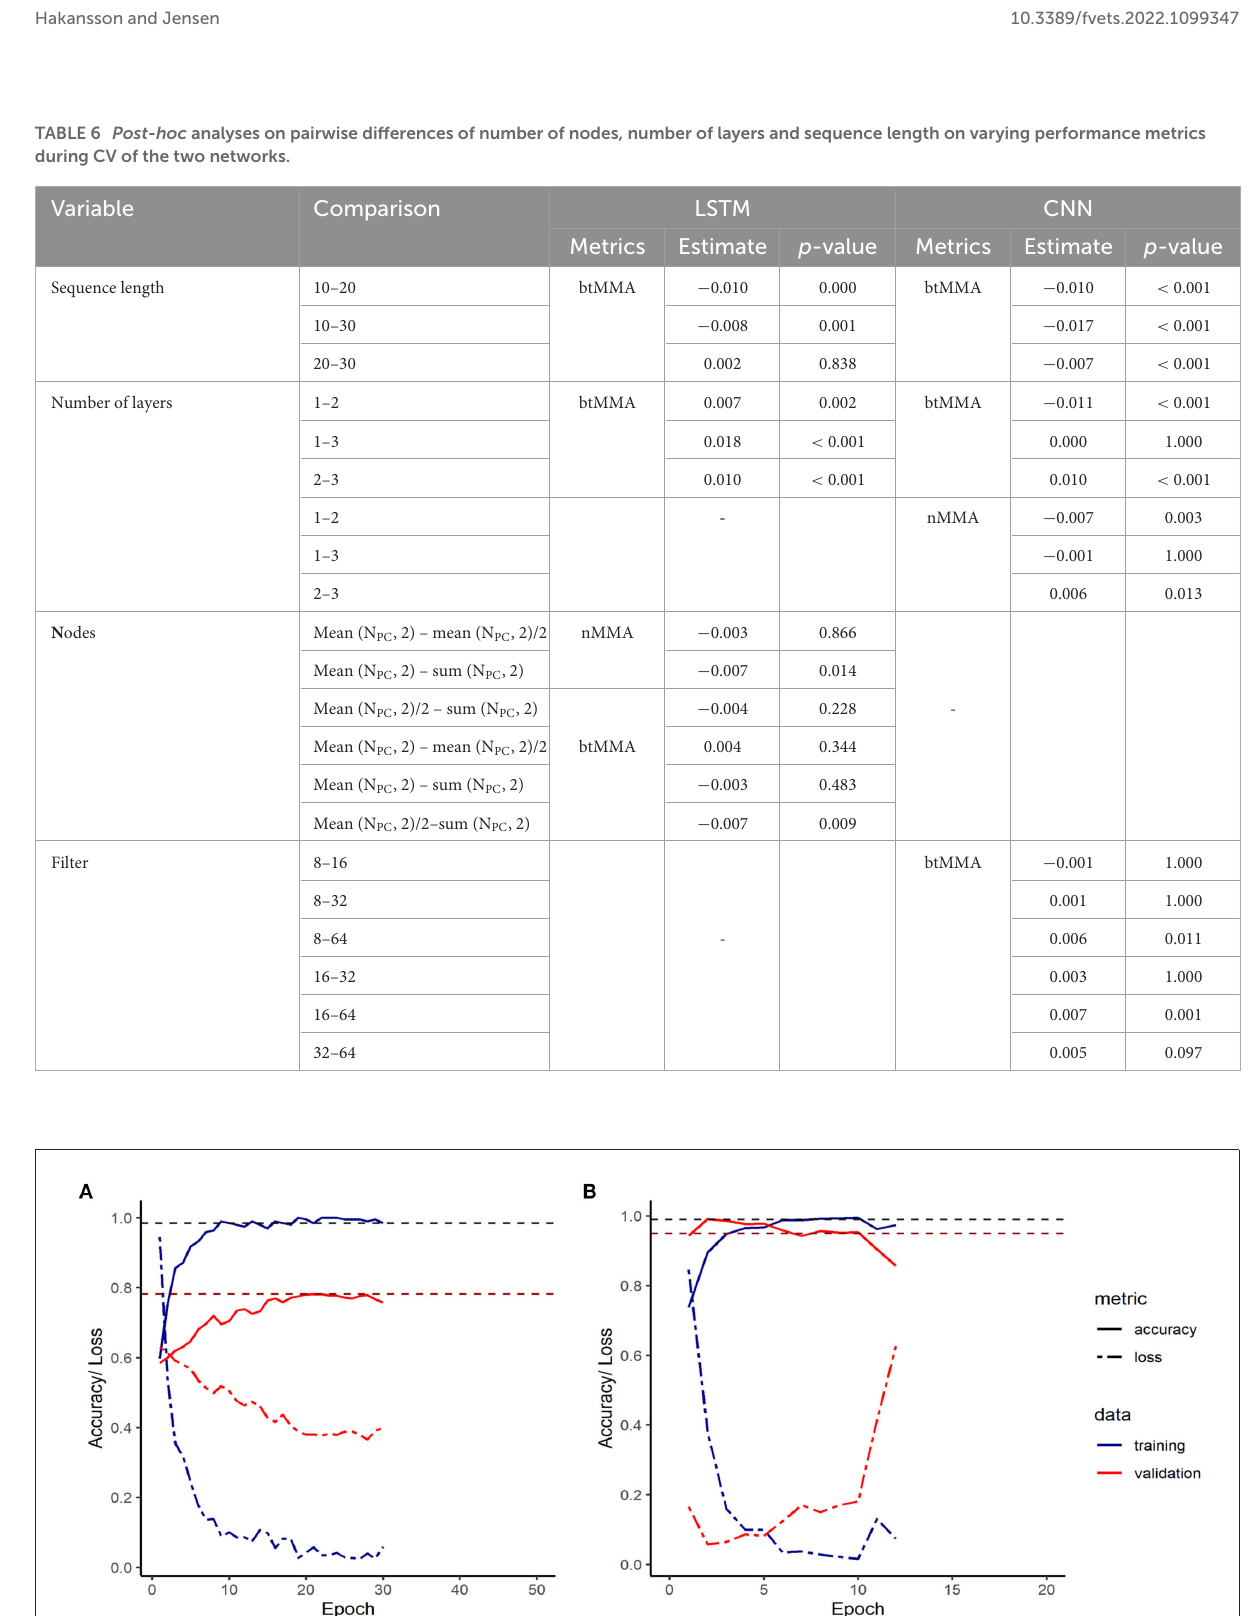
TABLE 6 Post-hoc analyses on pairwise differences of number of nodes, number of layers and sequence length on varying performance metrics during CV of the two networks. Variable